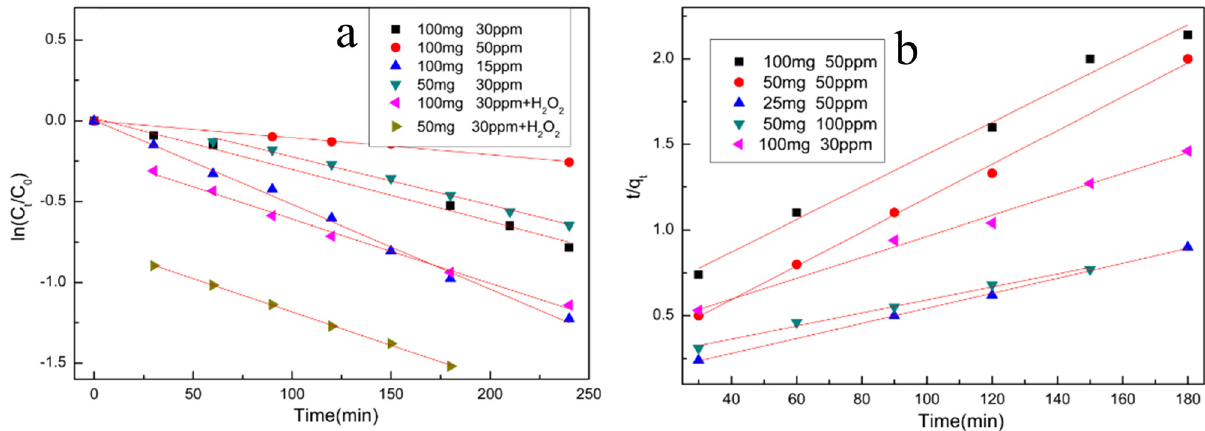
Figure 9: The kinetic model of Zn - MOFs: ( a ) pseudo - fi rst order and ( b ) pseudo - second order.